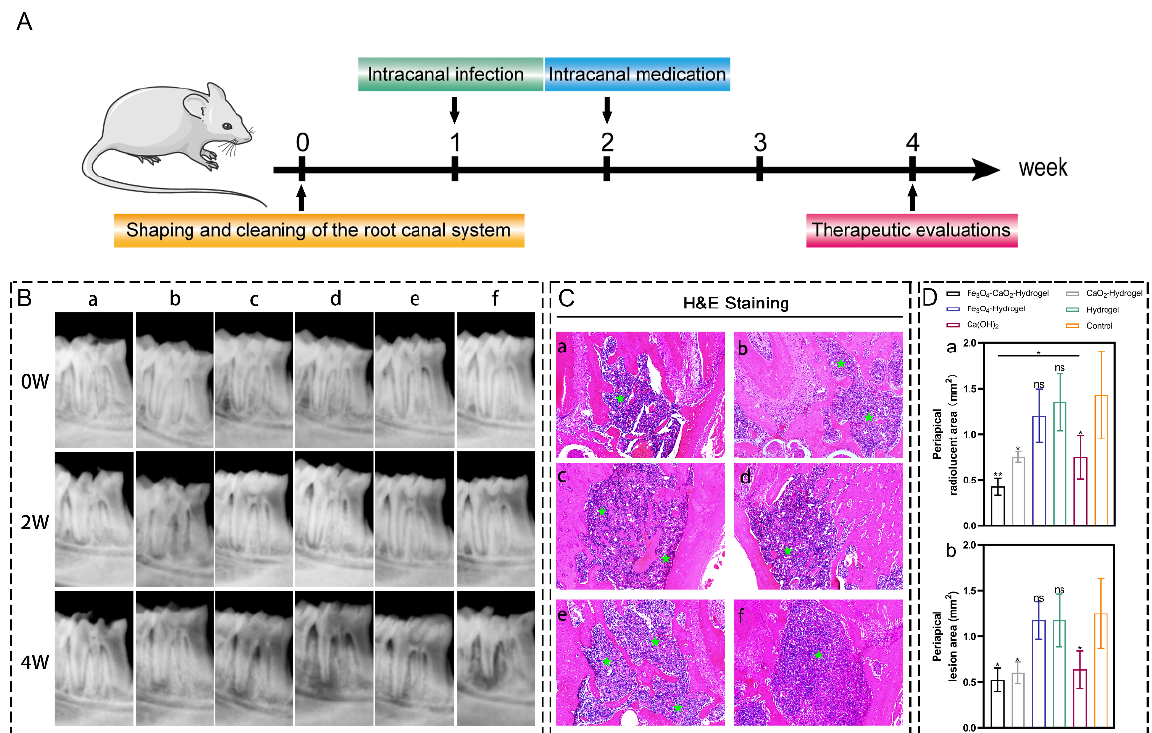
Figure 5. ( A ) Schematic diagram of in vivo experiment results. ( B ) After root canal preparation (0 week), intracanal medication (2 weeks), and postoperative (4 weeks) radiographs. a: Fe 3 O 4 -CaO 2 -